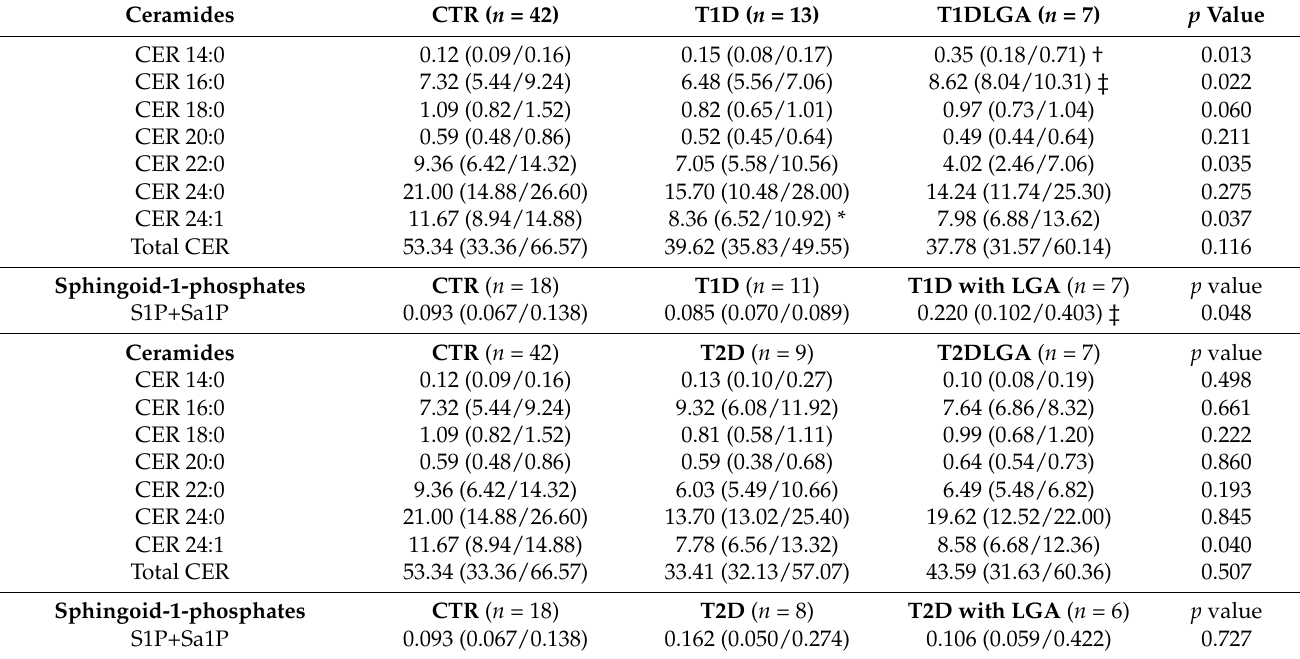
Table 3. Placental sphingolipids in maternal pre-existing diabetes with and without fetal